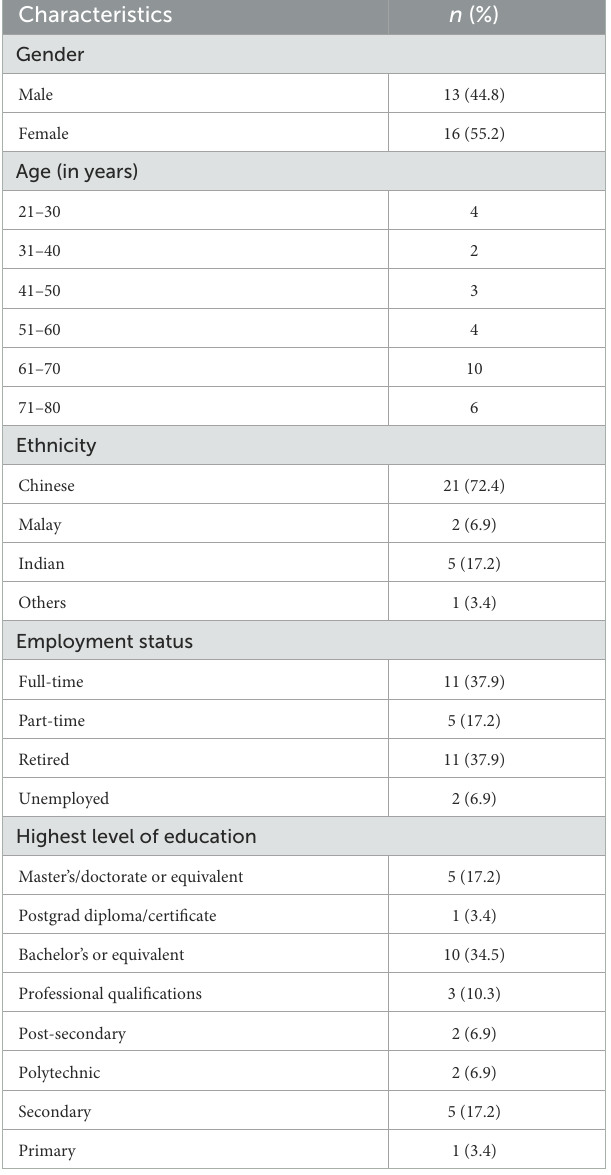
TABLE 1 Participant demographics ( n =